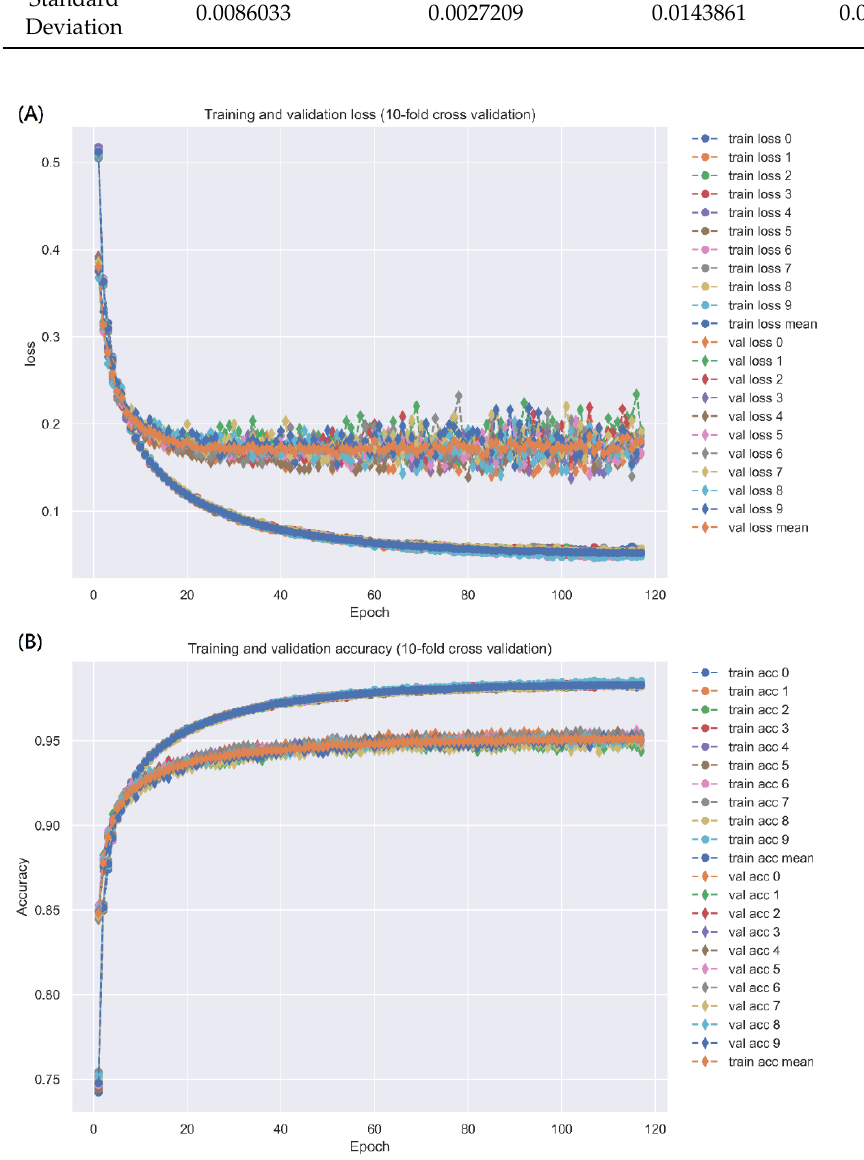
Figure 5. The training and validation loss is represented in ( A ), and the training and validation accuracy is represented in ( B ). The early stop is adopted to avoid overfitting to stop at epoch = 117.